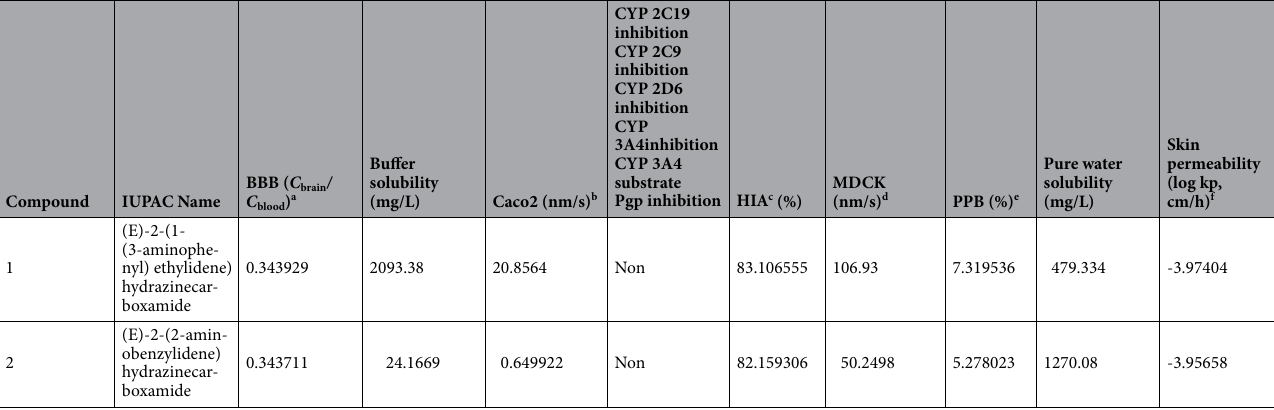
Table 4. The ADME features of the selected compounds predicted by PreADMET web server. a In vivo blood brain–barrier penetration—( C brain /C blood ) for high absorption to CNS > 2.0; middle adsorption to CNS: 2.0 ≈ 0.1; low absorption to CNS < 0.1. b In vitro caco2 cell permeability—Low < 4; middle: 4–7; high > 7. c Human